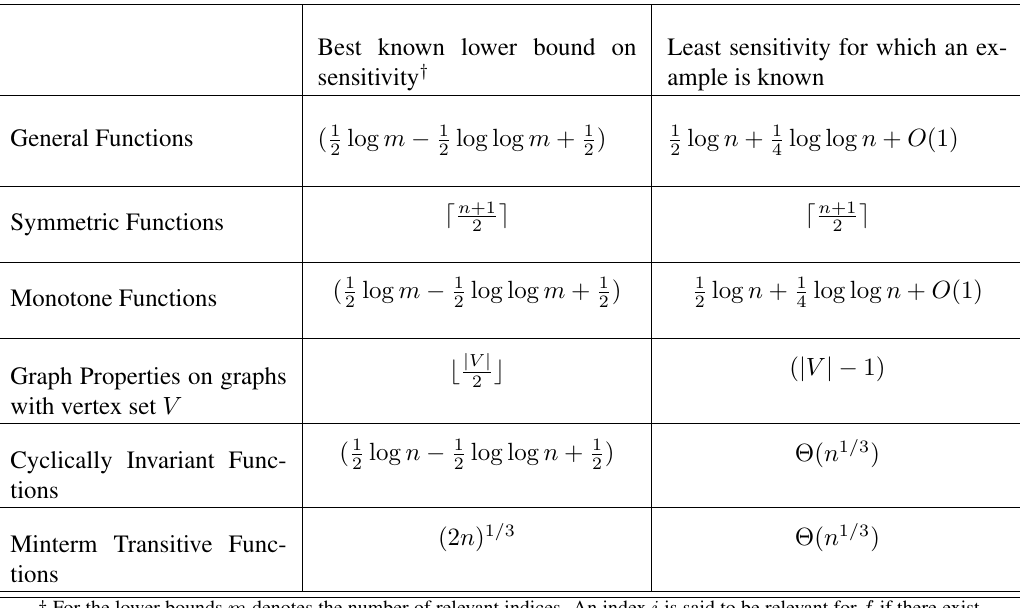
Tab. 1: Current knowledge about sensitivity of some classes of Boolean